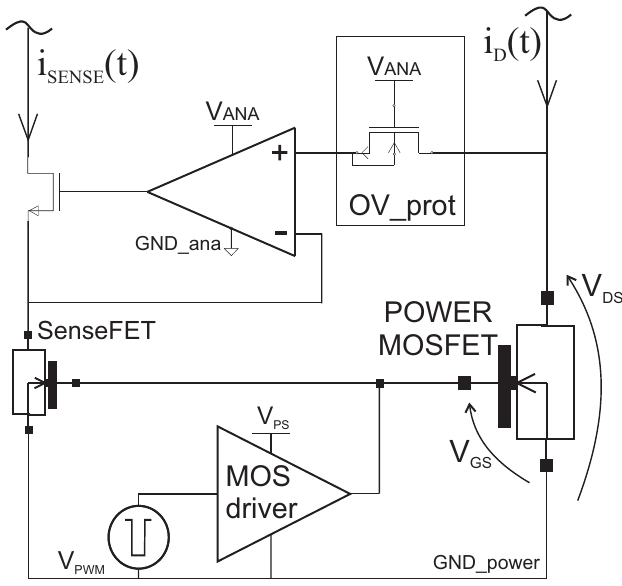
Figure 1. Current sensor based on the SenseFET